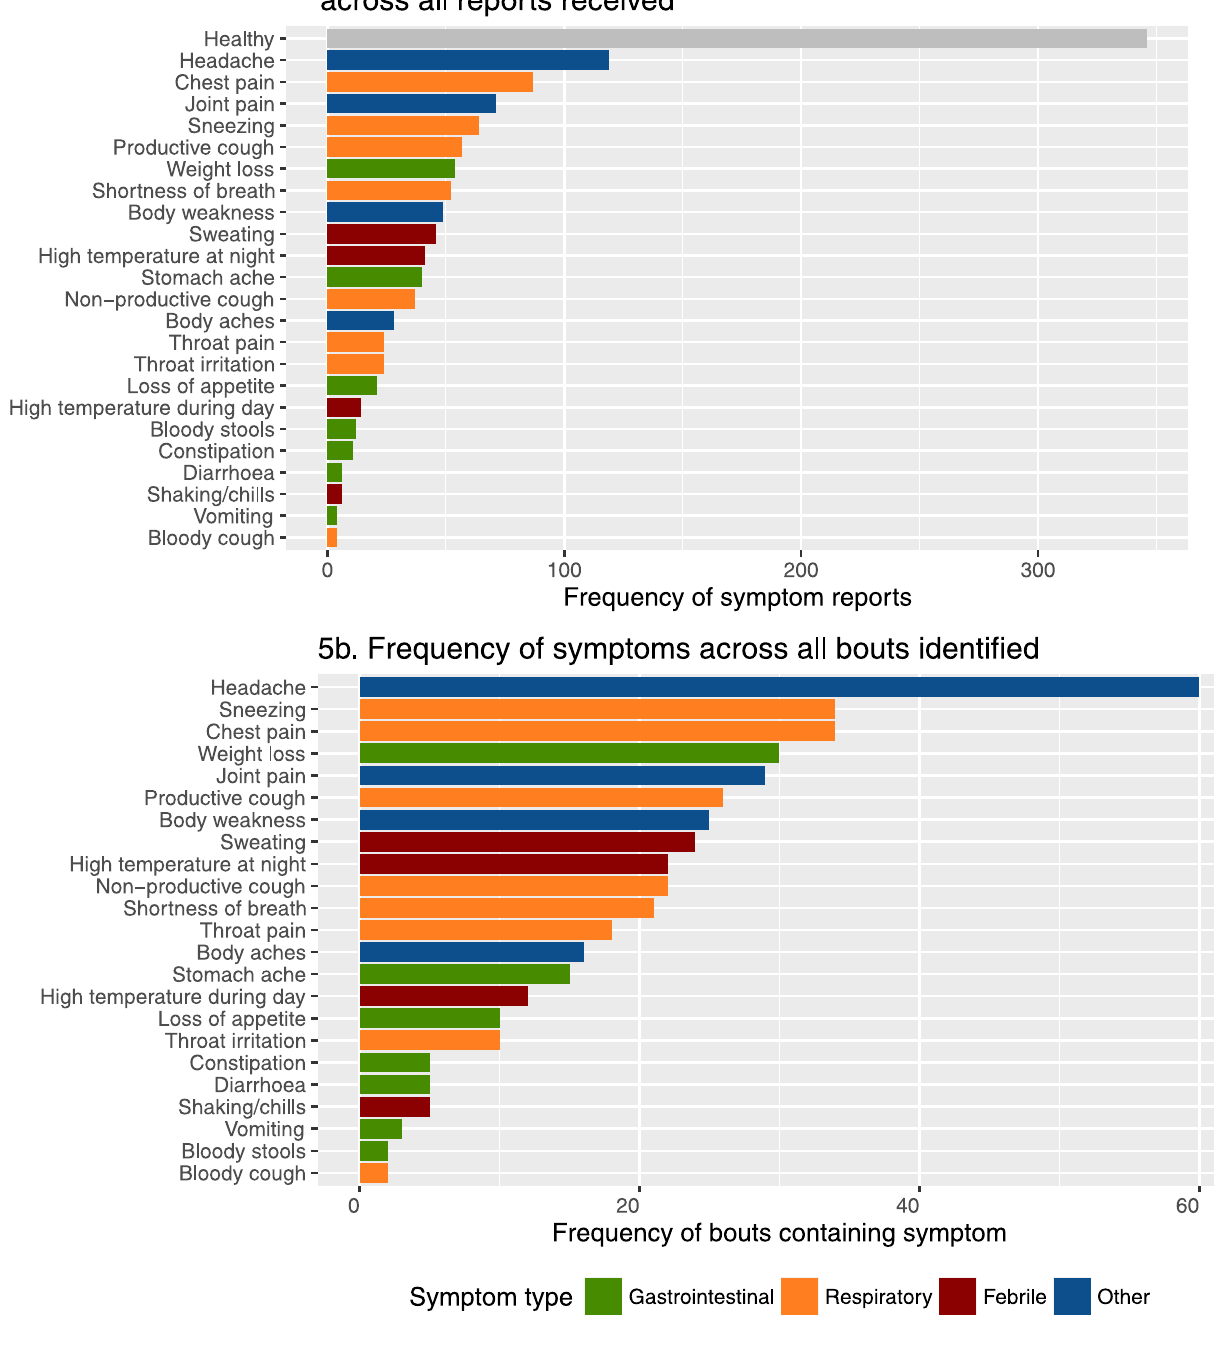
PLOS ONE | DOI:10.1371/journal.pone.0155971 June 9,